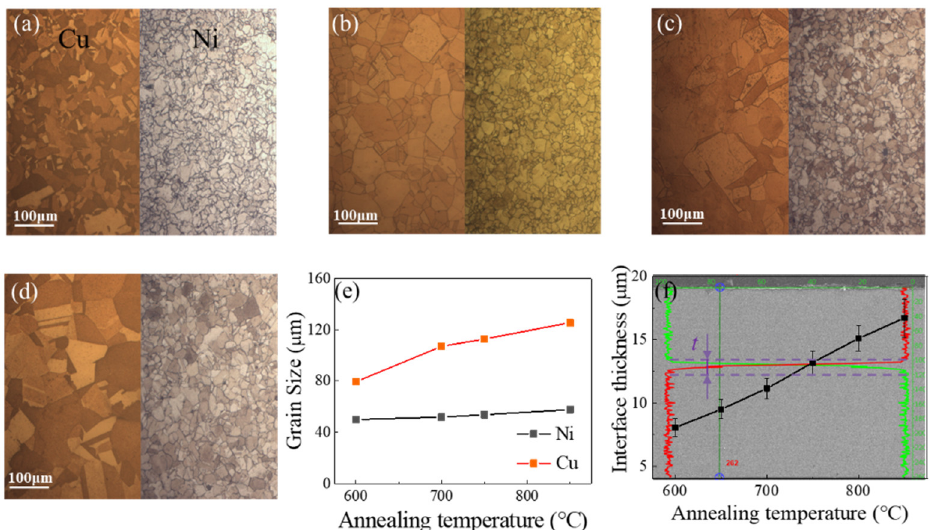
Figure 1. Microstructures of Cu and Ni layer under different annealing temperatures: ( a ) 600 °C, ( b ) 700 °C, ( c ) 750 °C, ( d ) 850 °C, ( e ) variation of grain size of Cu and Ni layers after annealing, and ( f ) variation of thicknesses of the interface layer.